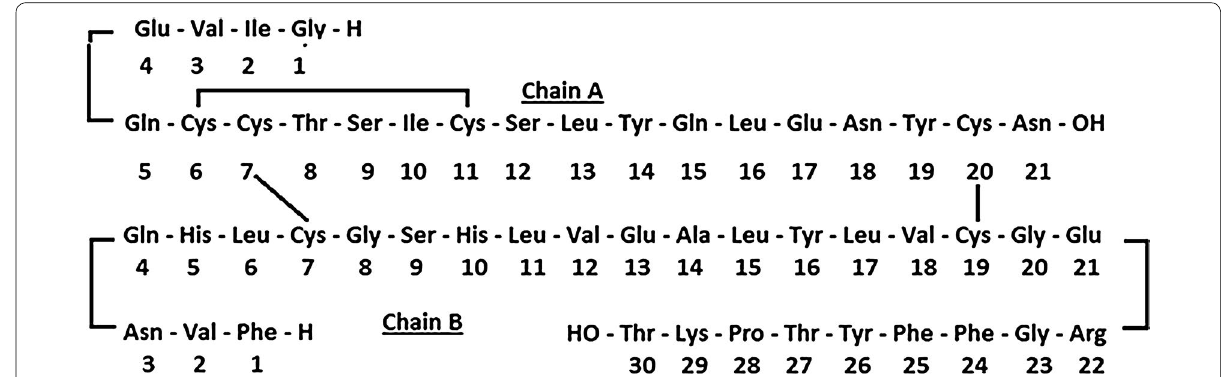
Fig. 1 Insugen (I) HR insulin: amino acid sequence. In the porcine insulin sequence ThrB30 is mutated to